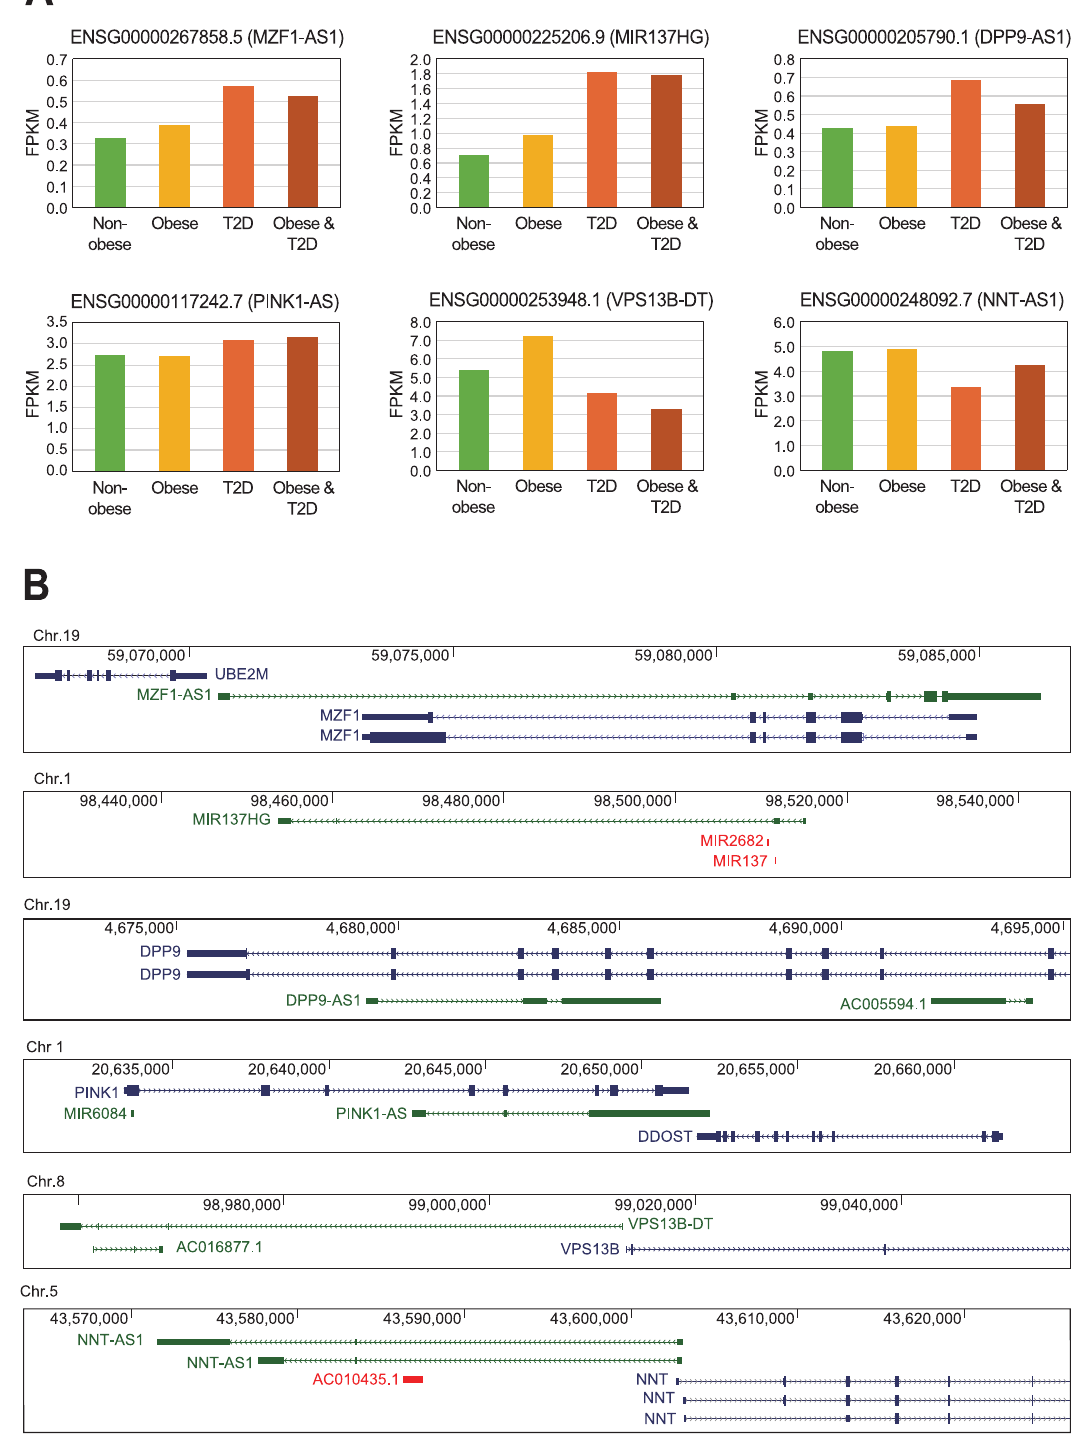
Fig 2. Selected dysregulated long non-coding RNAs (lncRNAs) identified in the myotubes of patients with diabetes. (A) The expression of specific lncRNAs in each of the sample groups was calculated based on the data available in the public GSE81965 dataset, and is reported as Fragments Per Kilobase of transcript per Million mapped reads (FPKM) values. (B) Schematics describing the genomic context of each of the lncRNAs as reported in Genome Browser [24]. Blue lines represent protein-coding genes, green lines lncRNA genes, and red lines small non-coding RNA